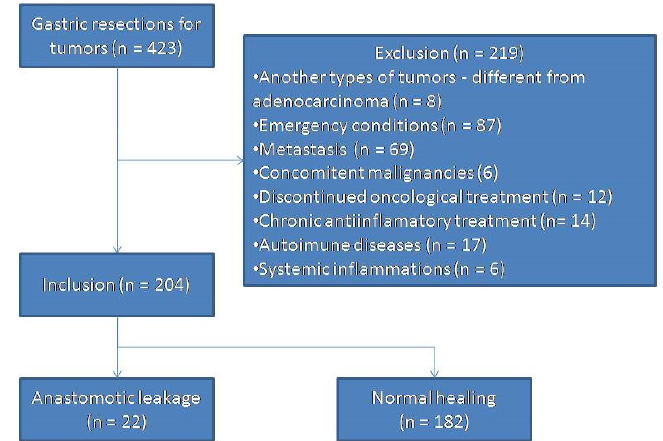
Figure 1. Flow chart of patient selection (NLR = neutrophil-lymphocyte